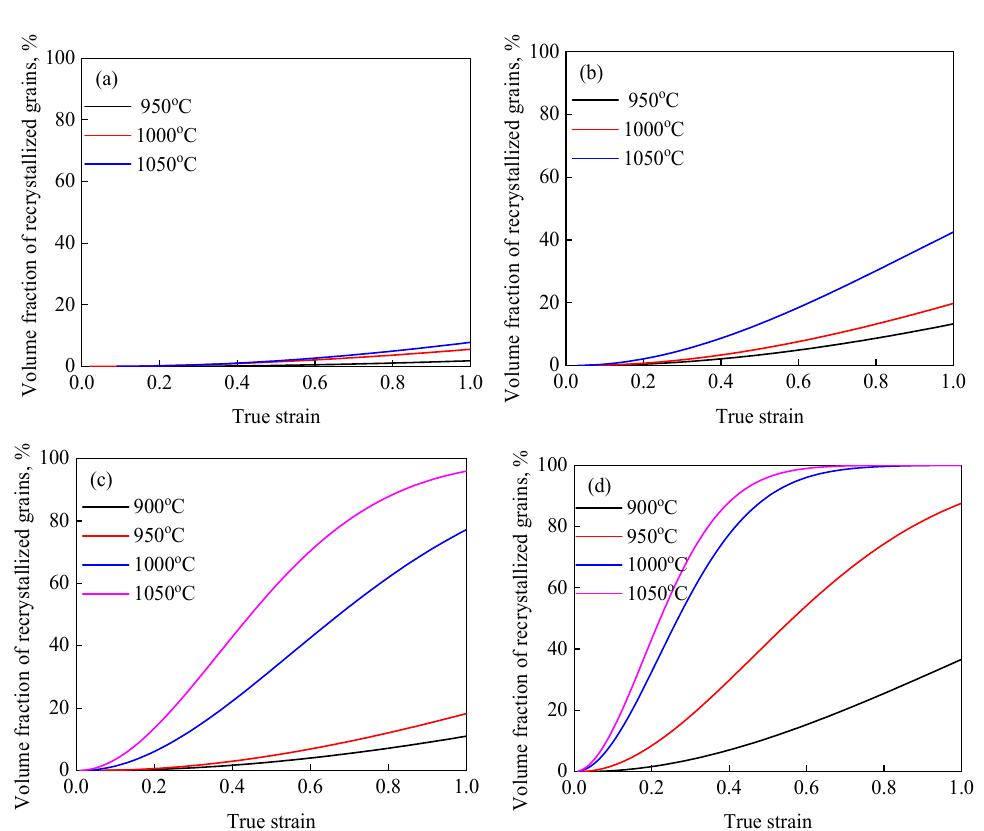
Figure 8. Variation in the X DRX with true strain at different temperatures of ( a ) 1 s − 1 , ( b ) 0.1 s − 1 , ( c ) 0.01 s − 1 and ( d ) 0.001 s − 1 .